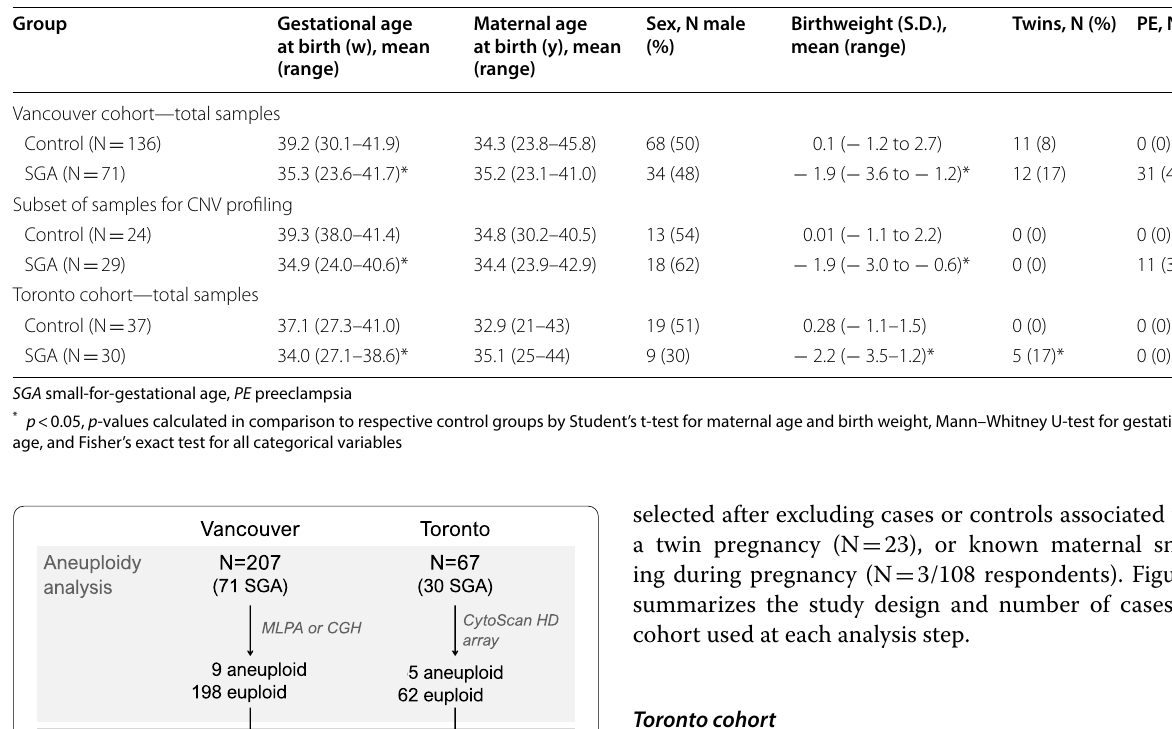
Table 1 Study cohort clinical characteristics